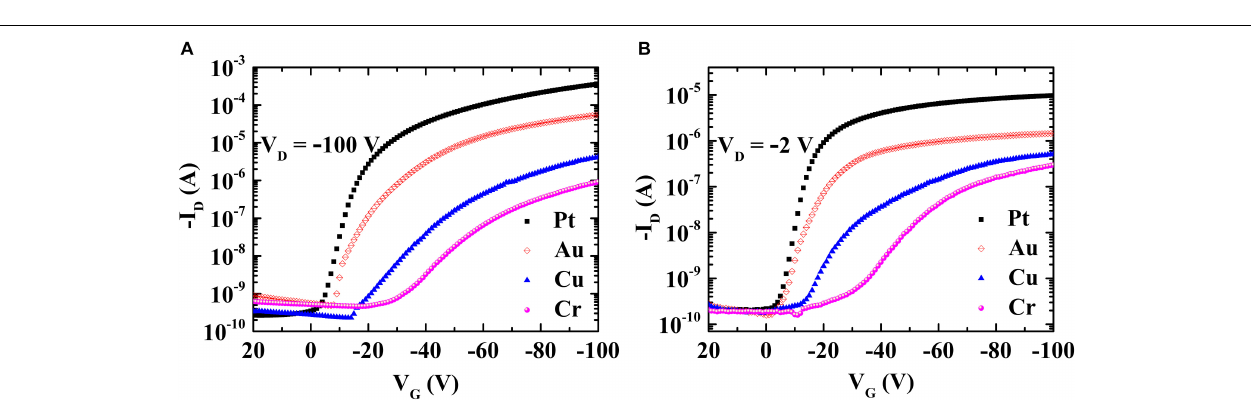
Frontiers in Materials |